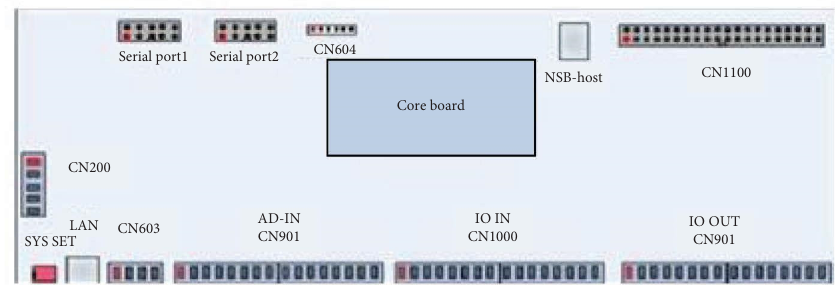
Figure 6: Control panel of arm board.